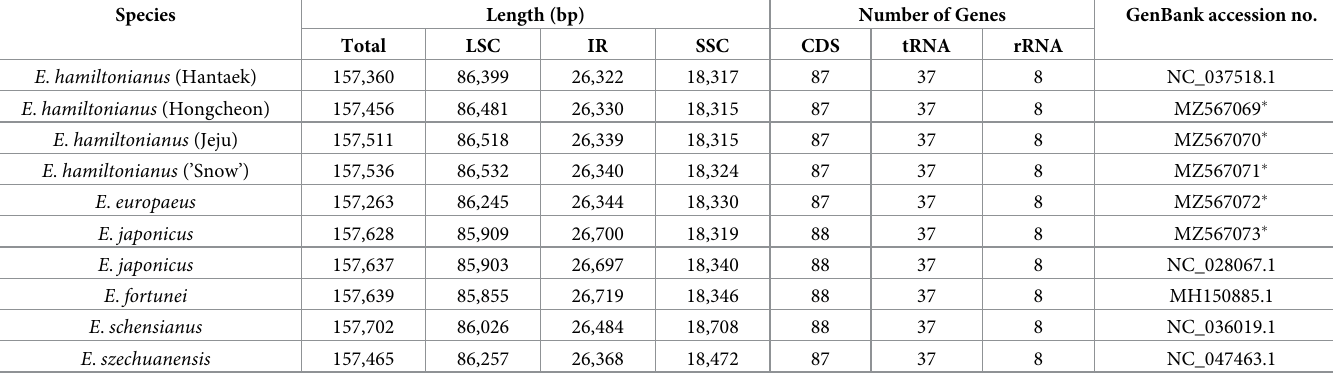
Table 1. Information about the plastomes of members of the Euonymus genus examined in this study.